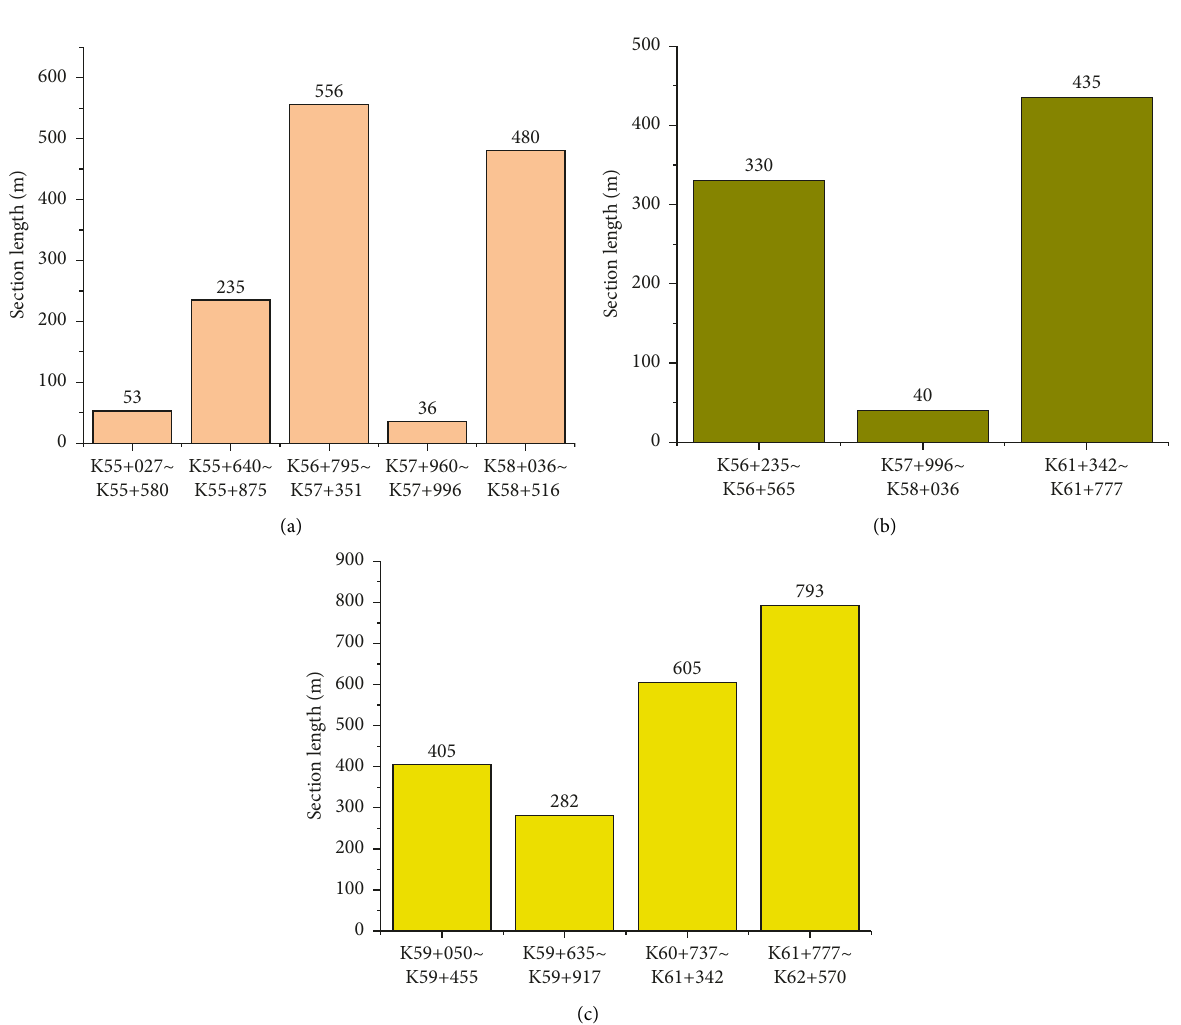
Figure 2: Dangerous zone of rockburst occurrence in tunnel. (a) Minor rockburst area. (b) Moderate rockburst area. (c) Severe rockburst